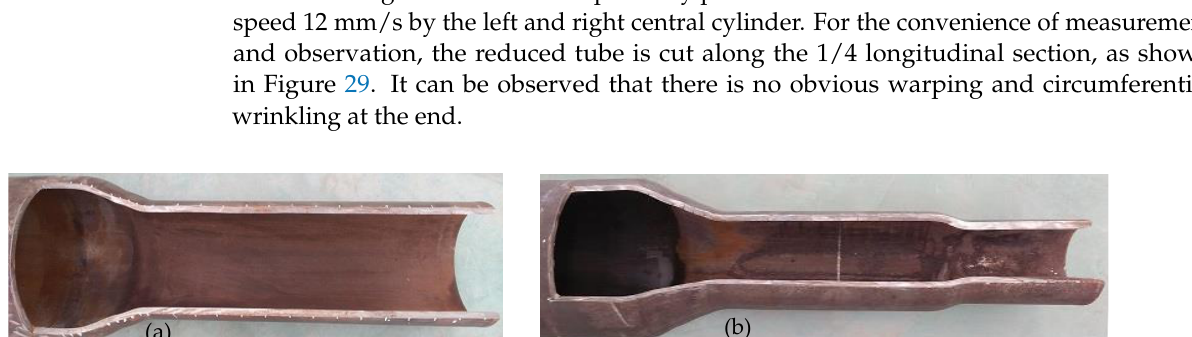
10 Figure 28. PPDR dies. 1. Left support cylinder; 2. Upper die base; 3. Left reducing die; 4. Left man- drel; 5. Upper clamping die; 6. Lower clamping die; 7. Lower die base; 8. Right mandrel; 9. Right reducing die; 10. Right support cylinder.